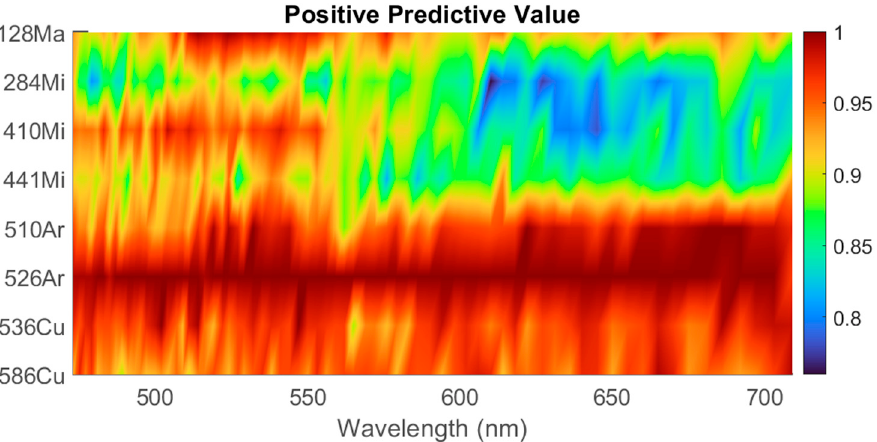
Figure 4. Positive predictive values for each organism in relation to the laser’s incident wavelength. The heatmap demonstrates that certain organisms are distinguished more effectively at specific